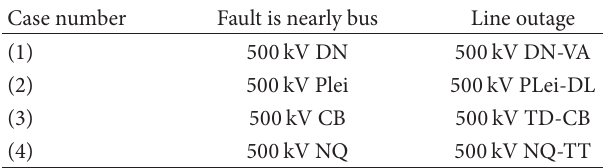
Table 5: Scenarios on three-phase fault for test of transient